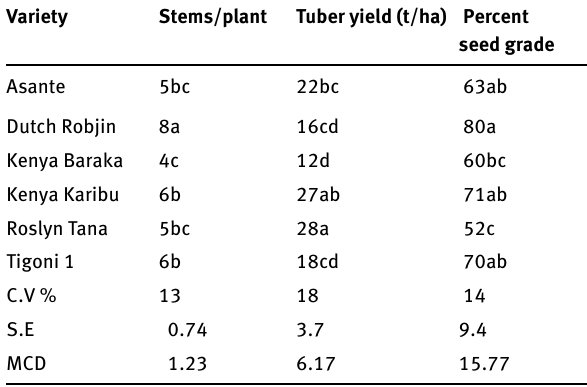
Table 2: Influence of variety on the stems/ plant, tuber yield and per